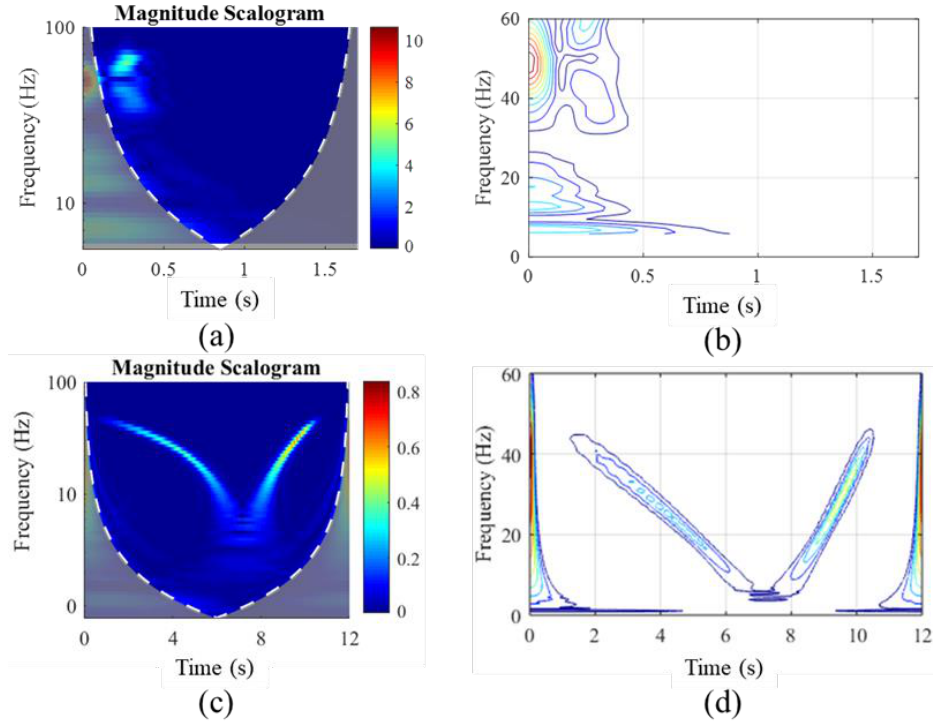
Figure 5. The time–frequency pattern of the simulated current with two broken bars at ( a ) the rated supply voltage, ( b ) the contour area of the maximum spectral density, ( c ) 10% of the nominal voltage and ( d ) the contour pattern for better legibility.